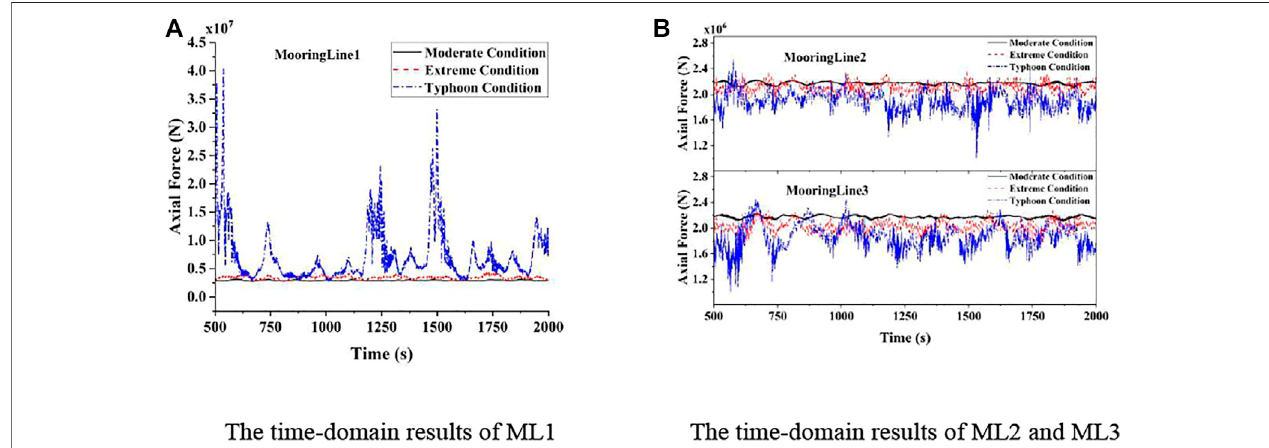
FIGURE 11 | Axial force of mooring lines under three different conditions. (A) Time-domain results of ML1. (B) Time-domain results of ML2 and ML3.